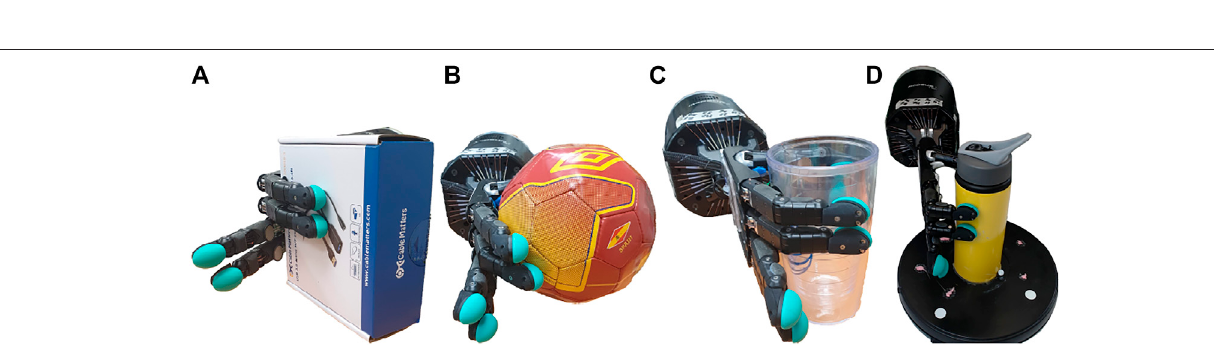
Frontiers in Robotics and AI |